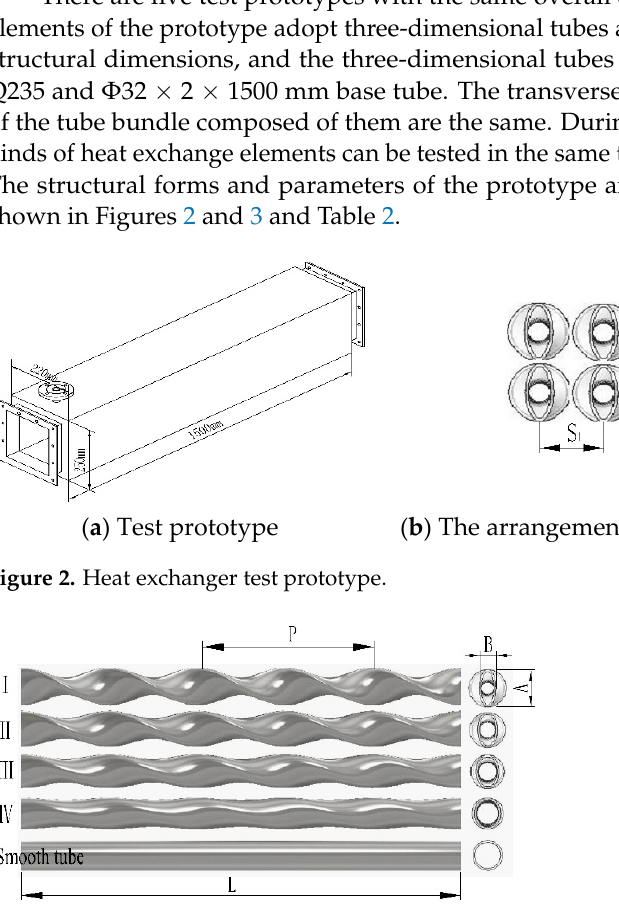
Figure 3. Schematic diagram of three-dimensional tube shape. Table 2. The main shape parameters of three-dimensional tube and smooth